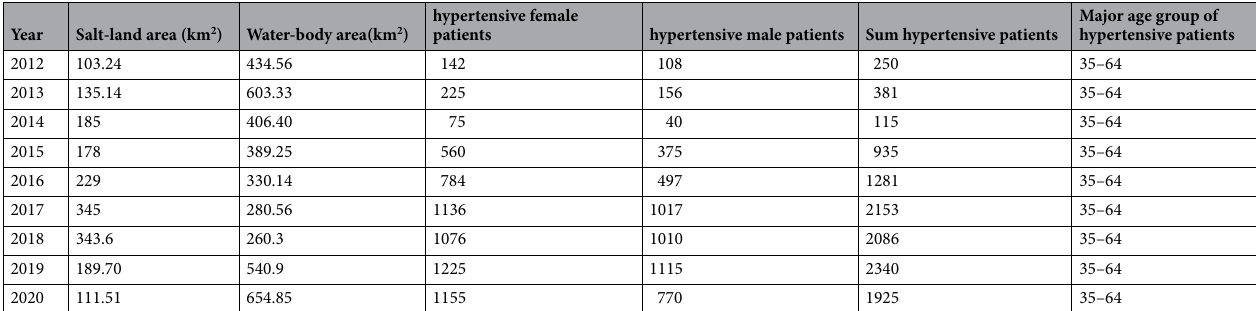
Table 5. Time-series analysis for salt-dust releases in the area north of the lake, as represented in Fig. 6, and percentage of hypertensive patients in each year obtained by the STEPS survey and health centers, as represented in Fig.